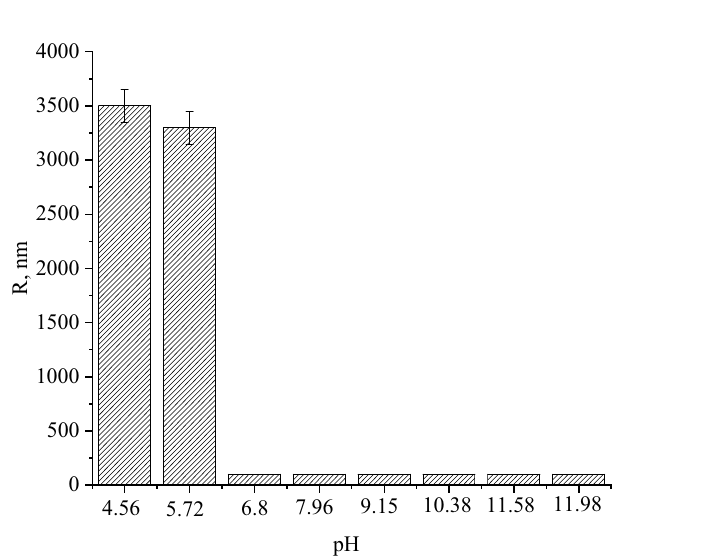
Figure 11. Dependence of the scattering intensity of the obtained CuO sols on the pH of the solution.